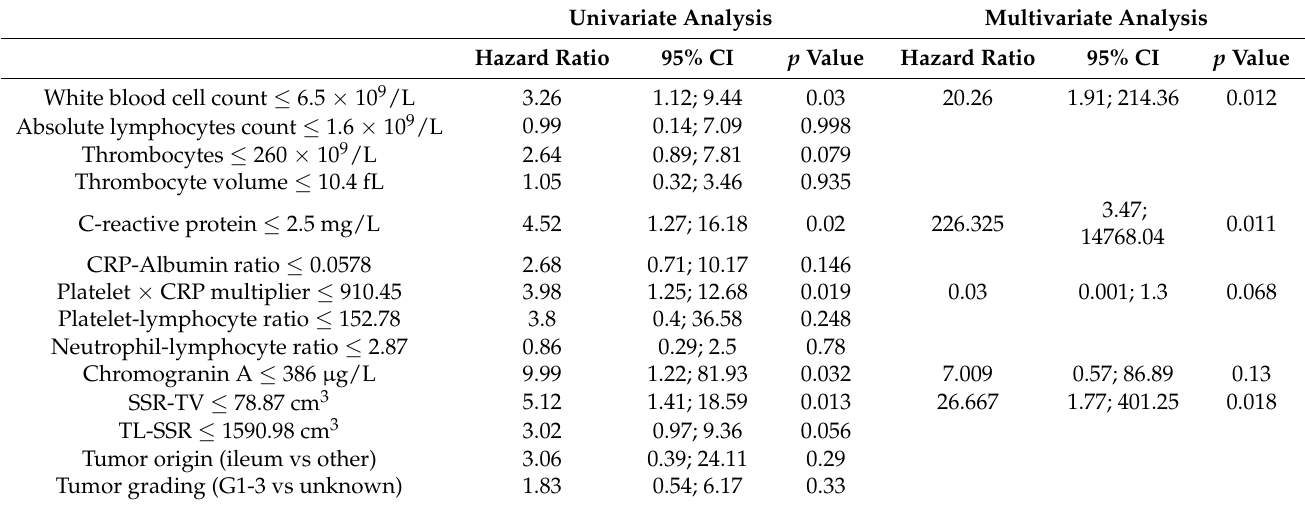
White blood cell count ≤ 6.5 × 10 9